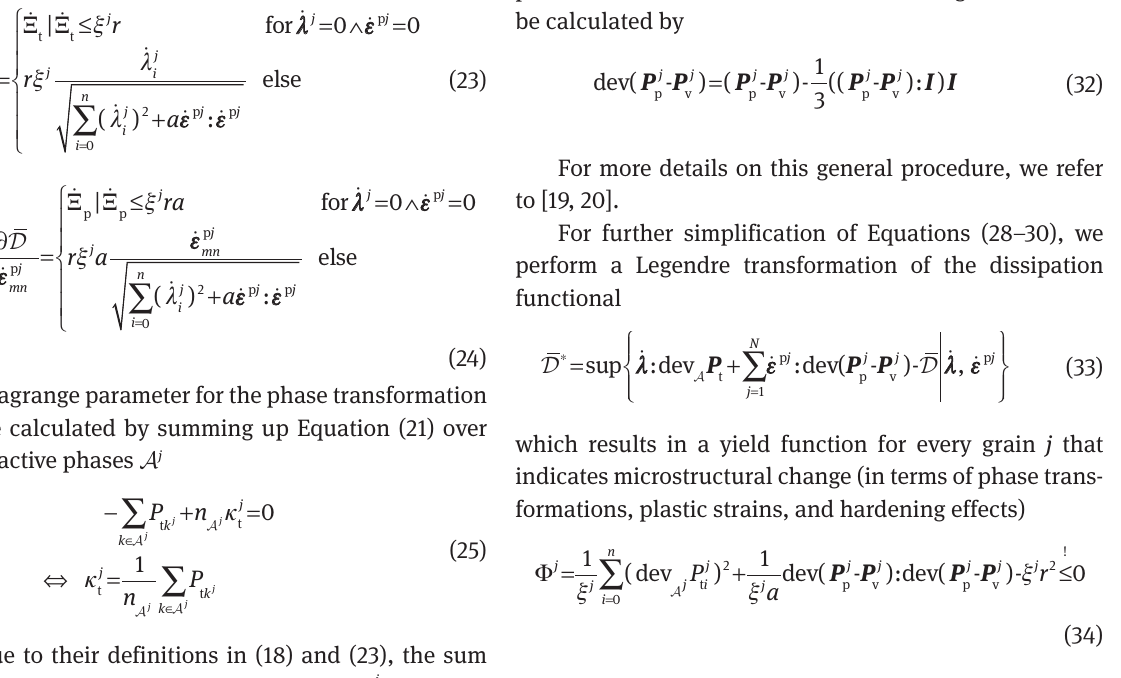
γ are 0. n A j i